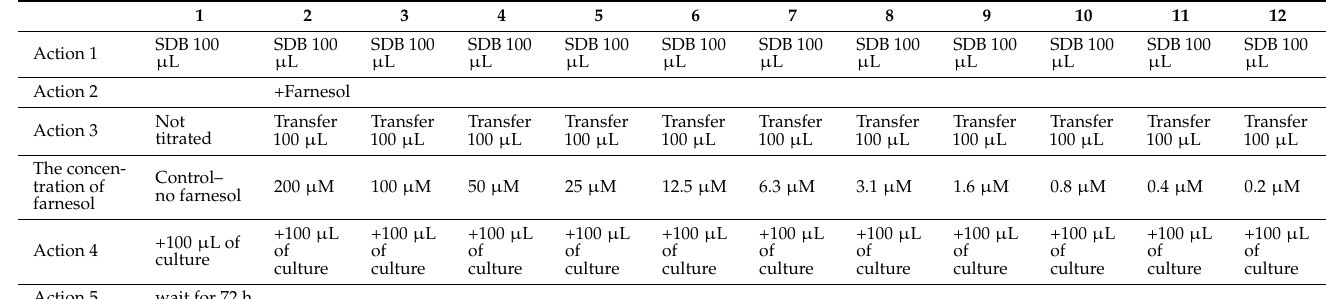
Table 1. Stages of the study of the Farnesol effect on M. pachydermatis biofilm